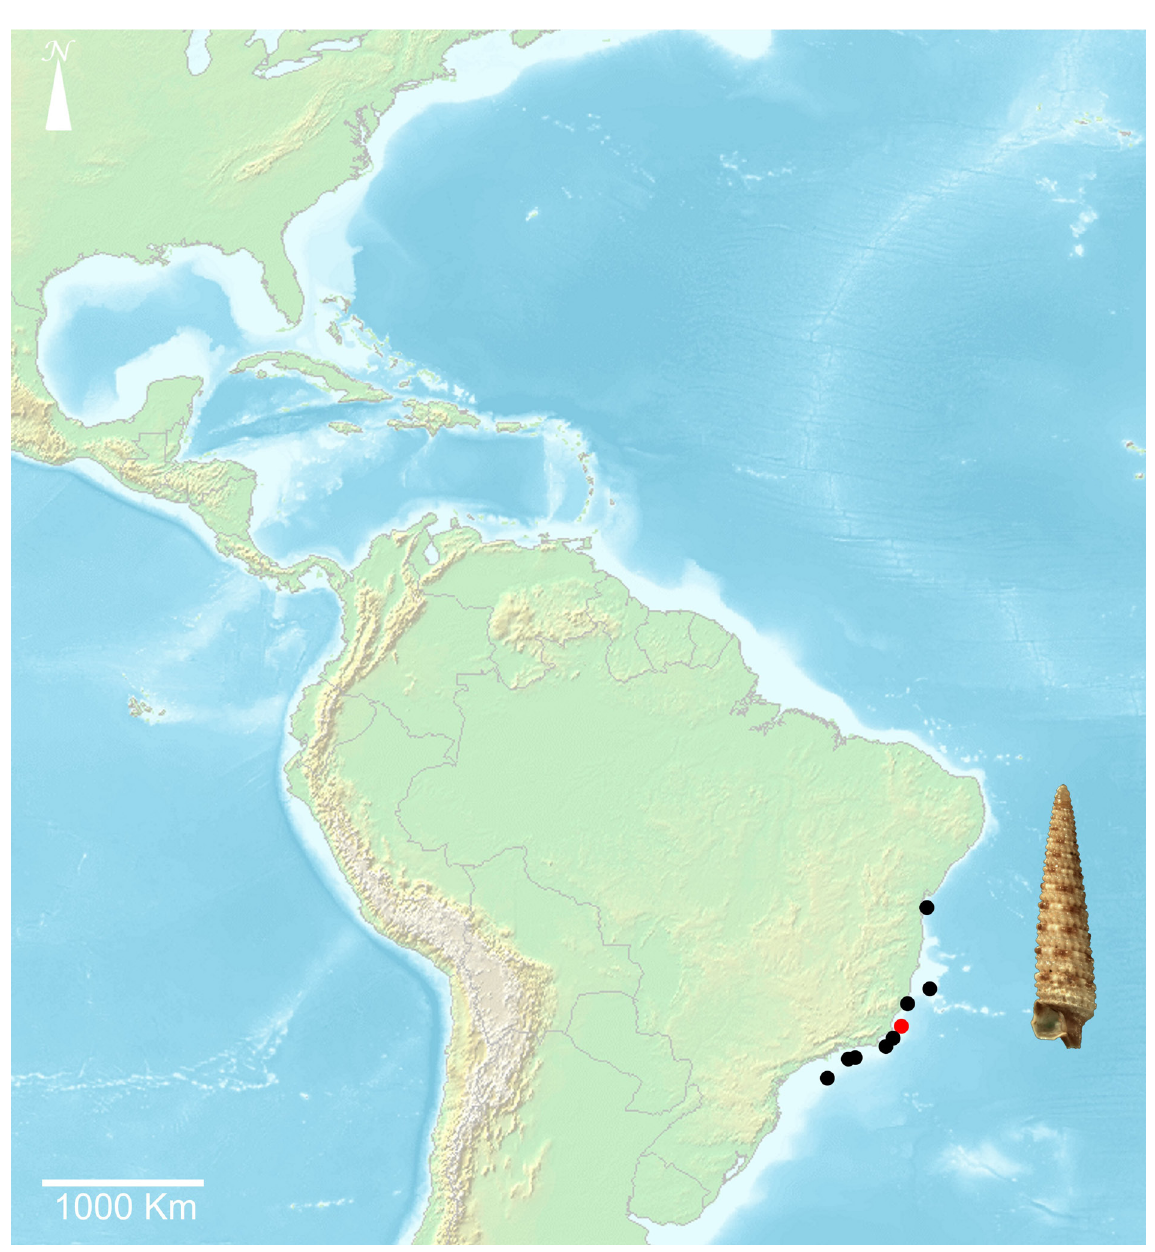
Fig. 39. Distribution map of “ Inella ” faceta Fernandes & Pimenta, 2019; red circle = type